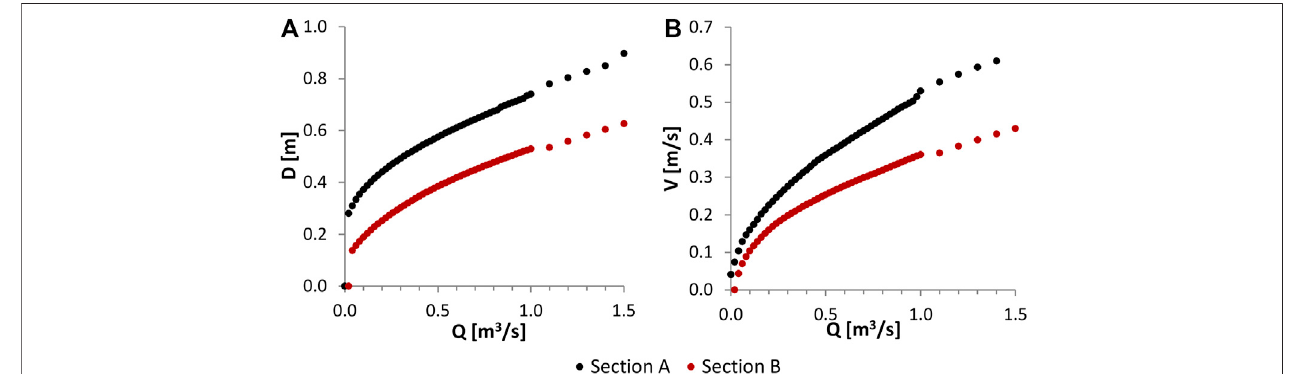
FIGURE 5 | Relationships between (A) depths (D) and fl ow rate, and (B) fl ow velocities (V) and fl ow rate.